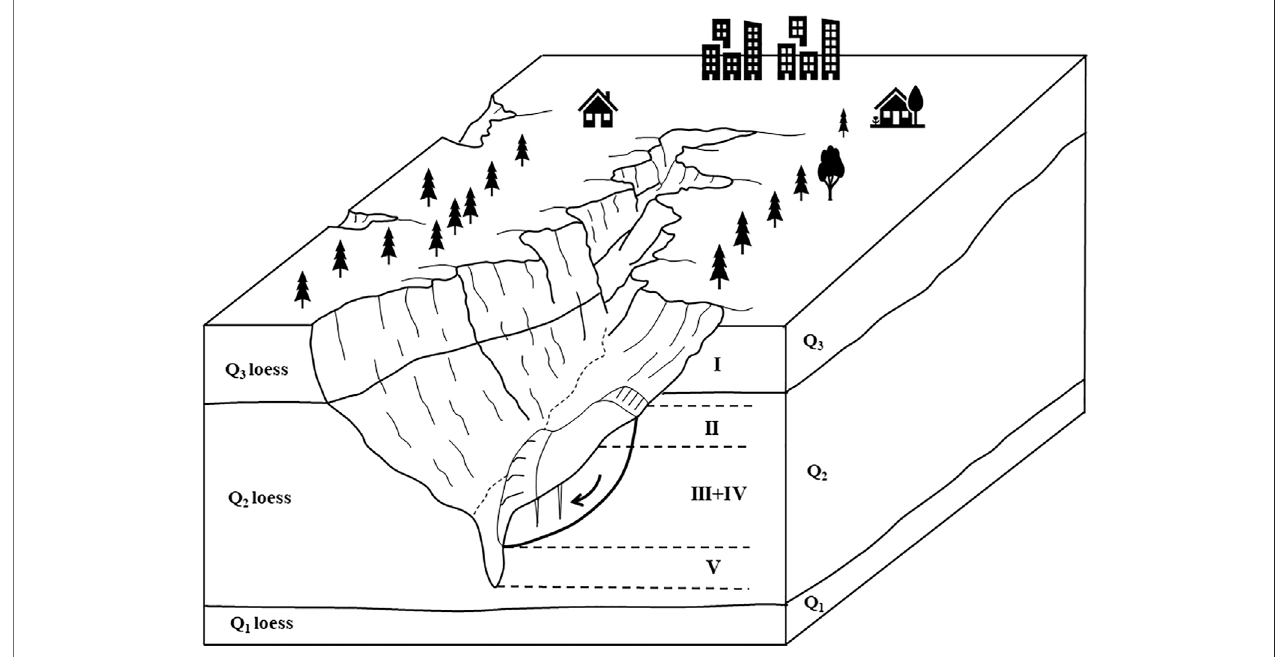
FIGURE 3 | Zonation of erosions at upstream of loess gully (modi fi ed from Zhang, 1980). I, sheet erosion zone; II, subsurface piping erosion zone; III, incising erosion zone; IV, gravitational erosion zone; V, scouring erosion zone).